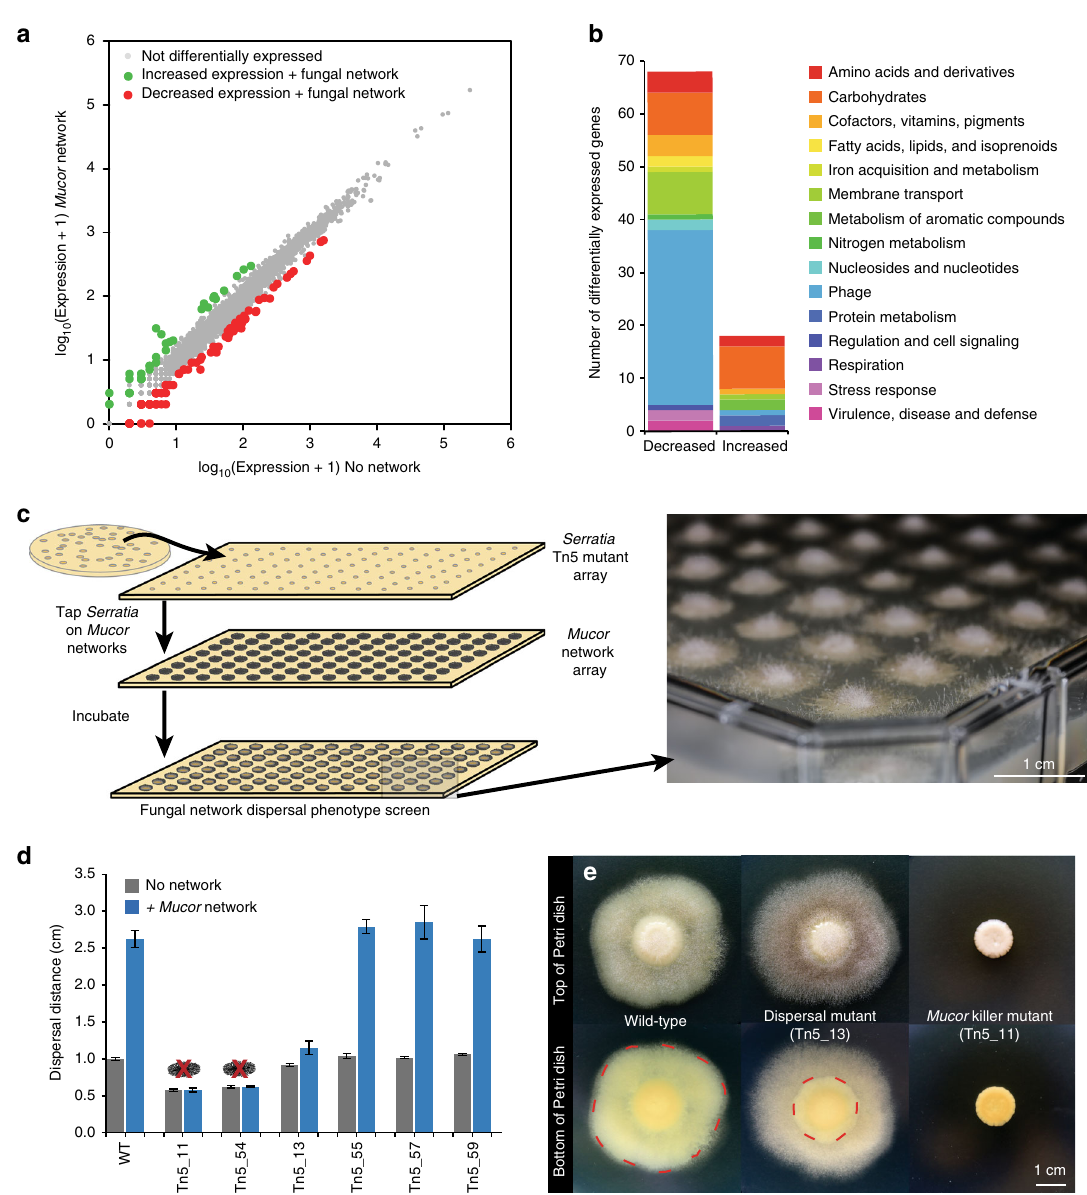
Fig. 3 Genetic mechanisms driving Serratia proteamaculans dispersal on Mucor networks. a Biplot of mean gene expression data from an RNA-seq experiment of Serratia with and without Mucor networks. Genes that had greater than 2-fold change in expression and deemed signi fi cantly different based on a q -value of < 0.05 ( p -values adjusted for false discovery rate using the Benjamini – Hochberg procedure) were considered signi fi cantly increased or decreased in expression. Genes increased in expression are indicated in green, decreased in red, and no change in gray. Three biological replicates were performed for each treatment. b Functional distribution of differentially expressed genes that were annotated with a putative function. Functions were determined based on SEED annotations from RAST. Decreased = signi fi cantly decreased expression on Mucor networks. Increased = signi fi cantly increased expression on Mucor networks. c Illustration of the Tn5 transposon mutagenesis screen for Serratia dispersal on Mucor . Serratia mutants were arrayed and spotted onto an existing Mucor array growing on PCAMS agar and the resultant plate was screened for changes in the dispersal phenotype. A photograph of an example screen plate is on the right (photo by Scott Chimileski and used with permission). d Dispersal distances along Mucor hyphae of putative Serratia Tn5 mutants compared to the wild-type Serratia , after 7 days of growth. Mutants Tn5_11 and Tn5_54 killed the fungal host and are marked with red “ X ” over mycelia. One mutant, Tn5_13, displayed limited dispersal along the fungal hyphae. Bars are mean distance from the center of the spot to the bacterial colony edge ( ± 1 standard deviation, n = 5). Dispersal assays were conducted on BHI agar. e Images of the wild-type Serratia , the dispersal de fi cient Tn5_13, and a killer mutant Tn5_11 with and without Mucor growing on PCAMS agar. The wild-type Serratia disperses to the edge of the hyphae, as outlined in red, while the dispersal de fi cient Tn5_13 does not disperse as far, as outlined in red. Mutant Tn5_11 completely inhibits the growth of Mucor . See Supplementary Fig. 6 for more genetic and phenotypic data from the selected transposon